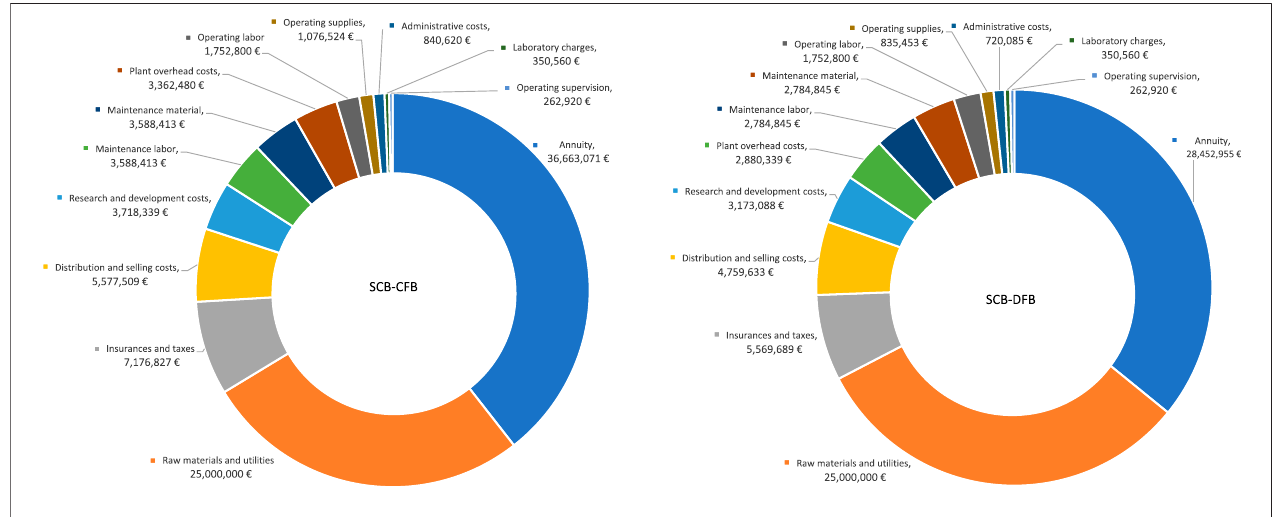
FIGURE 3 | Total production costs of the